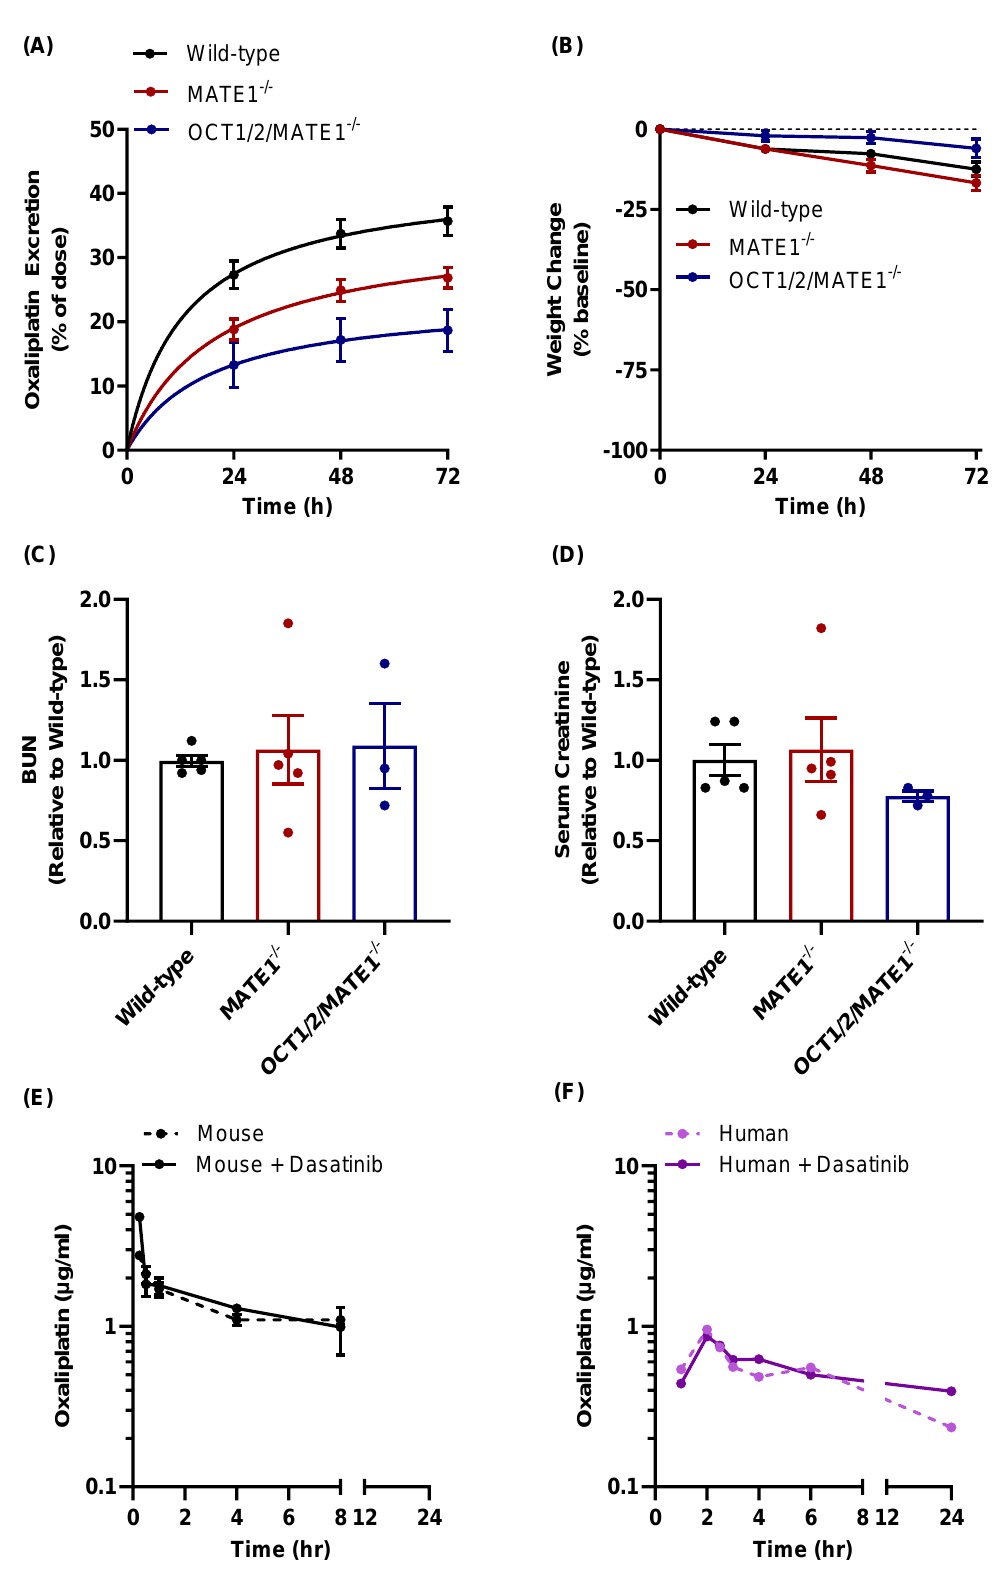
Figure 6. Influence of MATE1 inhibition on oxaliplatin disposition. Urinary excretion ( A ) weight loss ( B ), blood urea nitrogen (BUN) ( C ), and serum creatinine ( D ) were assessed in wild-type, MATE1-deficient, and OCT1/2/MATE1-deficient mice (n = 5 each) following a single dose of oxaliplatin (10 mg/kg, i.p.). Data represent mean ± SEM. Plasma concentration time profile of oxaliplatin in mice (10 mg/kg; i.p.) ( E ) and a human patient (85 mg/m 2 ; i.v. infusion) ( F ) in the presence and absence of pre-treatment with dasatinib at the dose of 15 mg/kg in mice, and 100 mg in a human